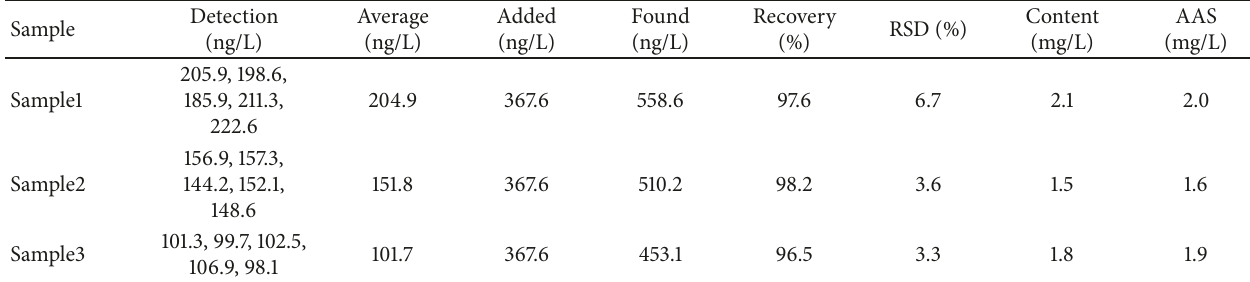
Table 2: Analytical results of Na + in